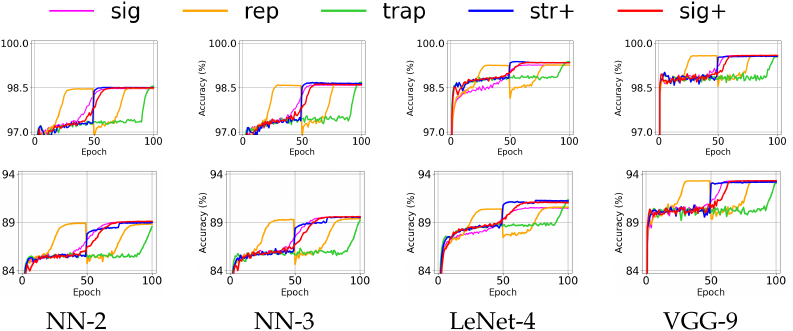
Figure 3. Shallow model with learning rate warmup. Accuracy curve over epochs for MNIST ( top row ), and Fashion-MNIST ( bottom row ) by SGD with different learning rate annealings: sigmoid function without warmup (sig), twice-repeated sigmoids (rep), trapezoid with 10%-epoch warmup (trap), staircase with the warmup (str+), and our sigmoid with the warmup (sig+): The per-epoch average of validation accuracy over 10 trials is shown in the y-axis where the range of accuracy is fixed for each data-set. Epoch (0, 1, 2, ..., 100) is shown in the x-axis.